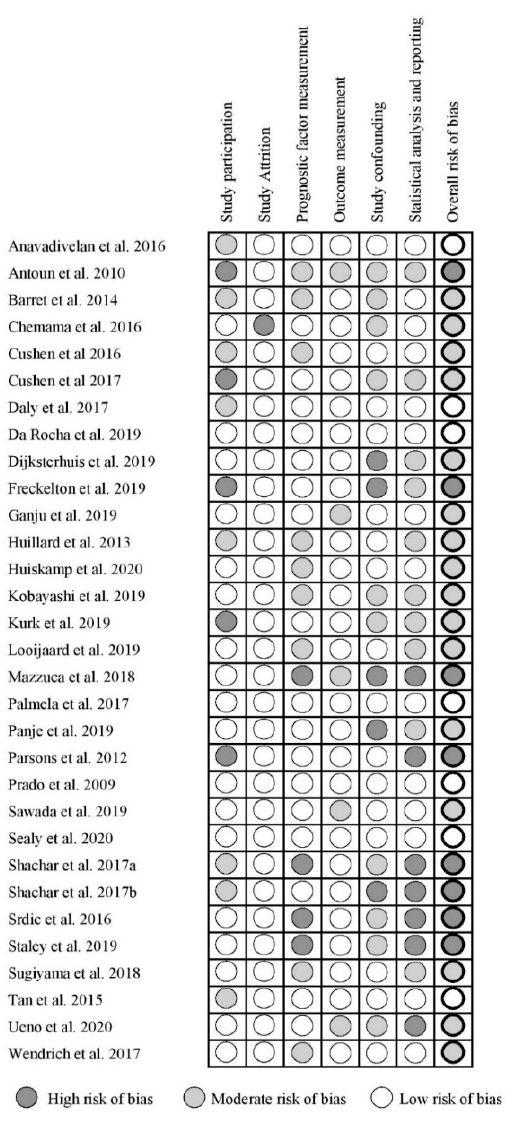
Figure 2. Quality in Prognostic Studies (QUIPS) for the included studies.